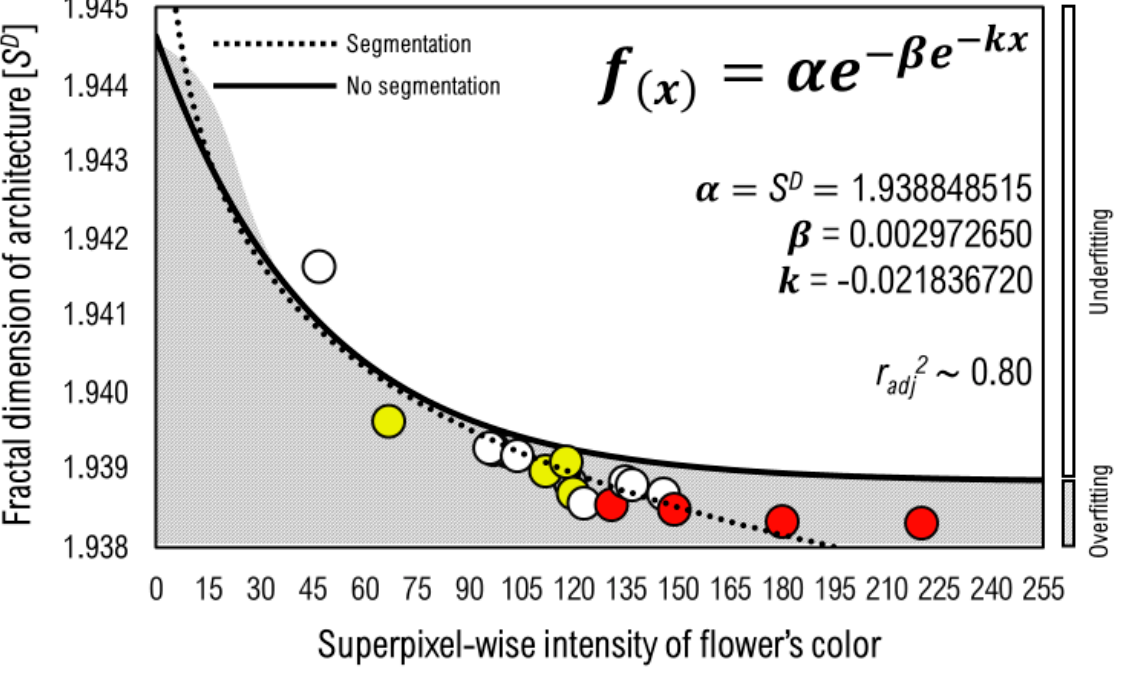
Figure 7. Predicting via Gompertz function the pixel-wise intensity of flower’s color upon the fractal dimension of architecture from high-resolution imagery data on white-color, yellow-color, and red-color varieties of P. umbraticola .